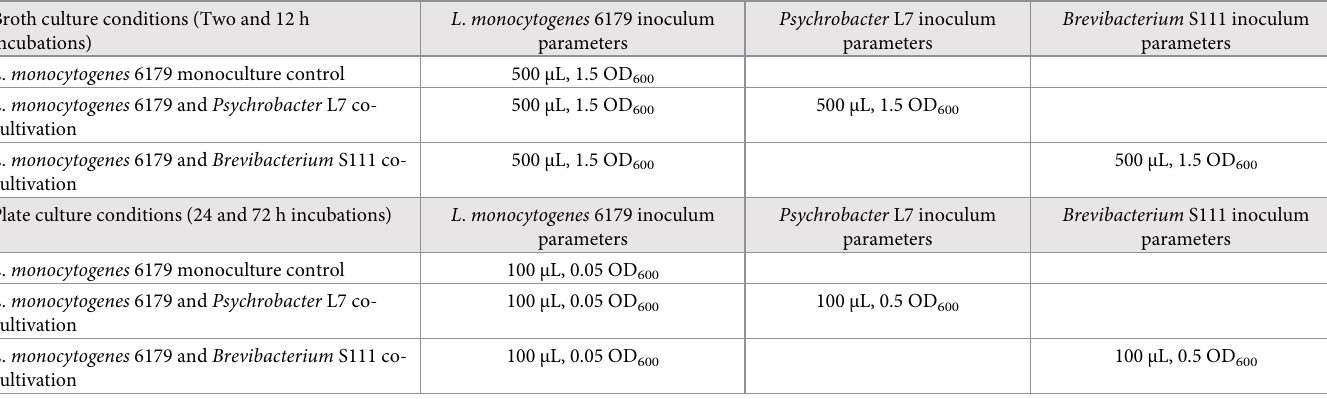
Table 2. Cultivation conditions of L . monocytogenes and cheese rind bacteria with inoculation parameters reported as volume and optical density (OD 600 ). Broth culture conditions (Two and 12 h